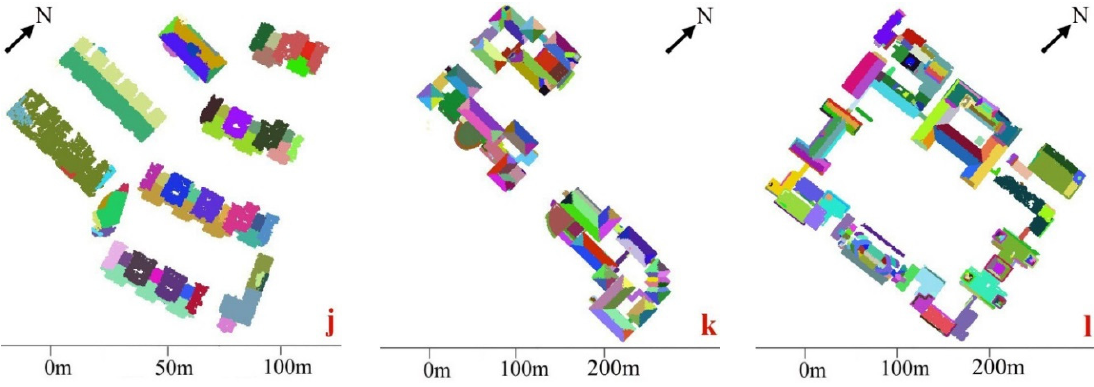
Figure 12. Segmentation results of Wuhan University data. ( g – l ) are six selected areas from the data. (top: image, bottom: results of BDSAC nv ).